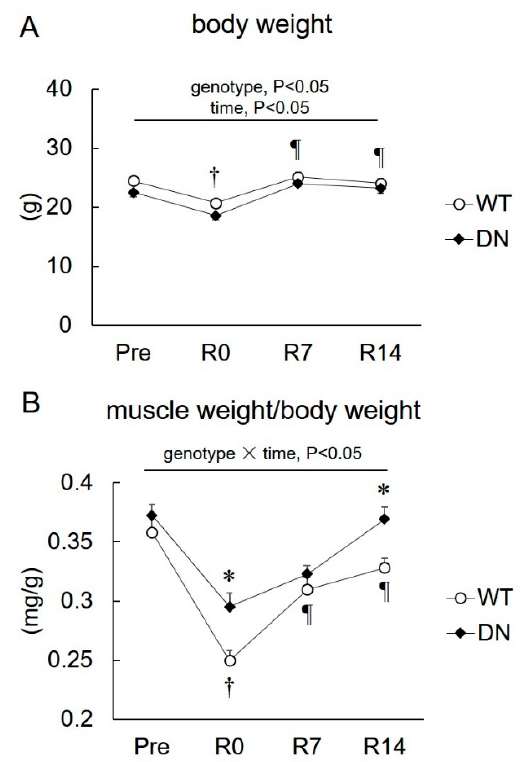
Figure 3. Changes in the body weight and soleus weight after 14 days of hindlimb unloading, and at 0, 7, and 14 days of reloading. ( A ) Body weight. ( B ) Relative soleus weight to body weight. Values are means ± SE; n = 8 per group. Statistical results of two-way ANOVA (genotype, time, and genotype × time) are described in the Figure. *, significant difference between genotypes at same time point. †, significant difference from Pre independent of genotype. ¶, significant difference from R0 independent of genotype.